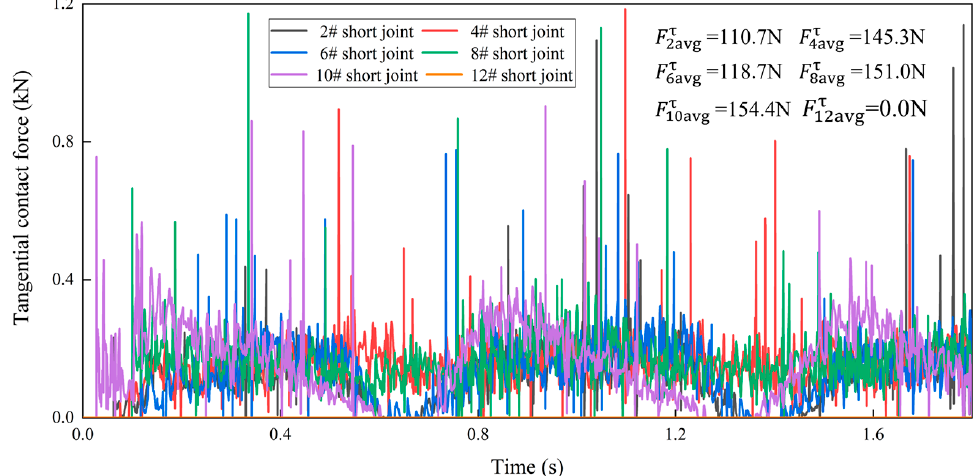
Figure 11. Variation curve of tangential contact force between flexible drill pipe and guide tube.